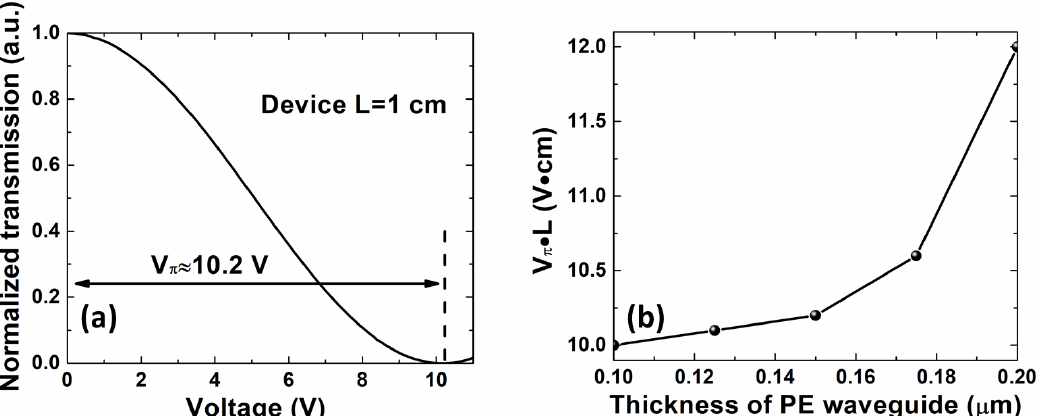
Figure 7. ( a ) Normalized optical transmission of a 1-cm device as a function of the applied voltage. ( b ) Half-wave voltage-length product variation with the thickness of the PE waveguide.